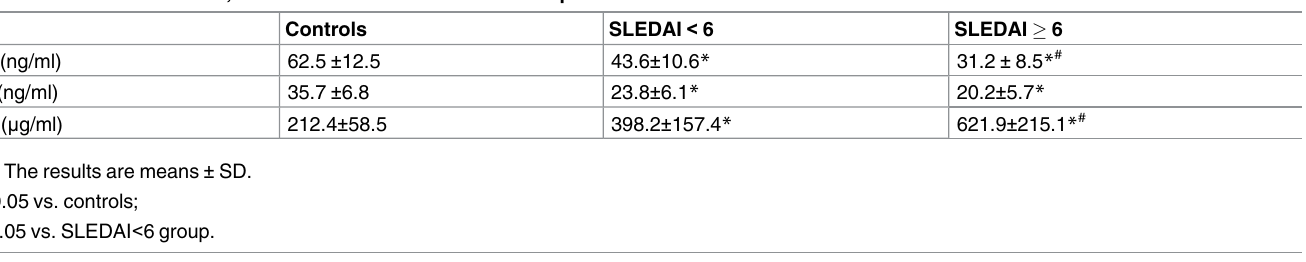
Table 1. Serum levels of SOD, CAT and CIC4 in controls and SLE